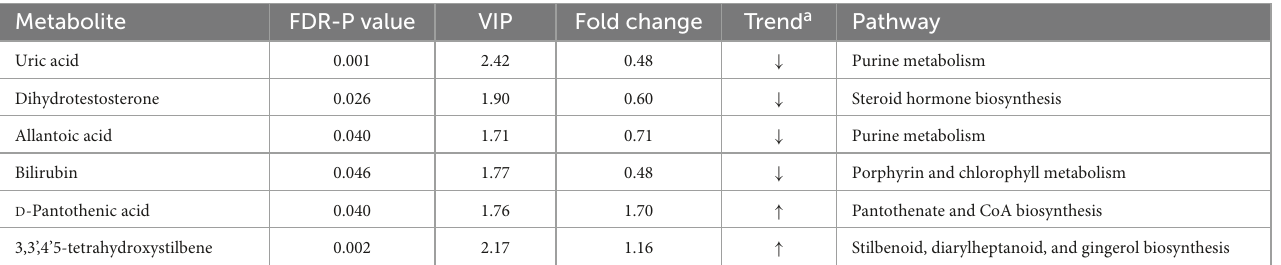
TABLE 2 Significant differential metabolites and their metabolic pathways derived from network analysis discriminated between ASD and TD children. Metabolite FDR-P value VIP Fold change Trend a